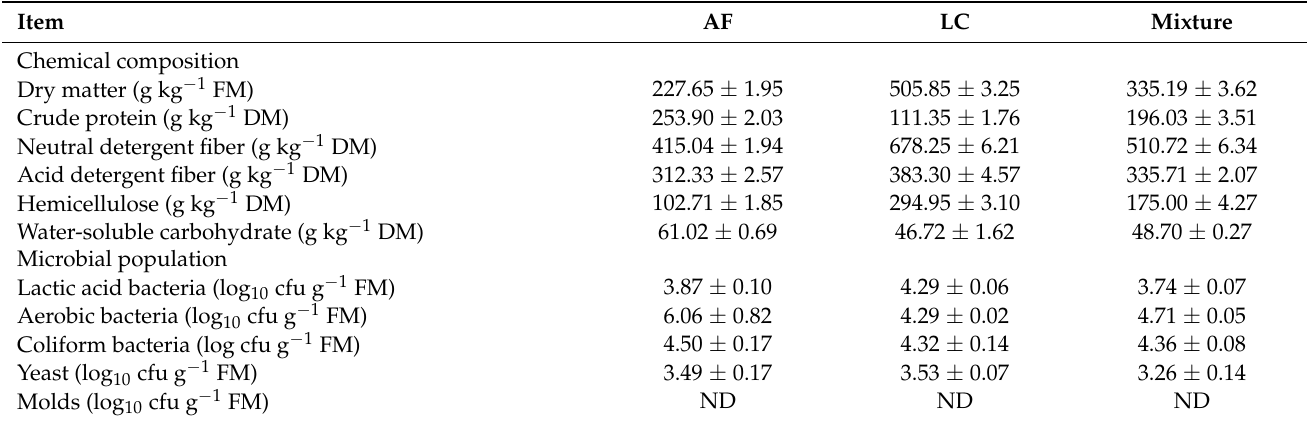
Table 1. Chemical composition and microbial population of alfalfa (AF) and Leymus chinensis (LC) before ensiling.